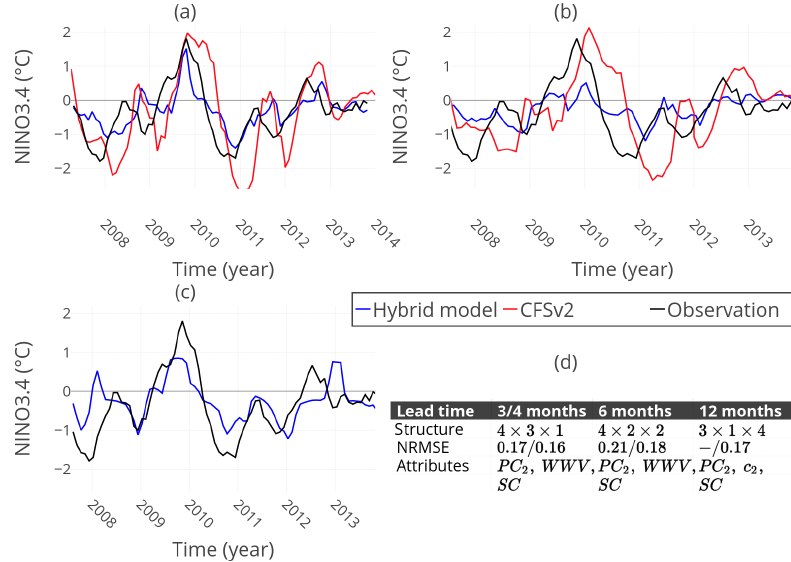
Figure 7. NINO3.4 predictions of the CFSv2 ensemble mean (red) and the hybrid model with ARIMA(12,1,0) (blue), compared to the observed index (black). For the hybrid model predictions, from an ensemble of 84 different ANN structures, structures resulting in a low NRMSE are presented. (a) The 3-month lead time prediction of CFSv2 and 4-month lead time prediction of the hybrid model, (b) the 6- month lead time predictions and (c) 12-month lead prediction. The CFSv2 ensemble does not predict 12 months ahead. (d) Table containing information about all predictions: ANN structures of the hybrid model, NRMSEs of the CFSv2 ensemble mean and the hybrid model, and attributes used in the hybrid model